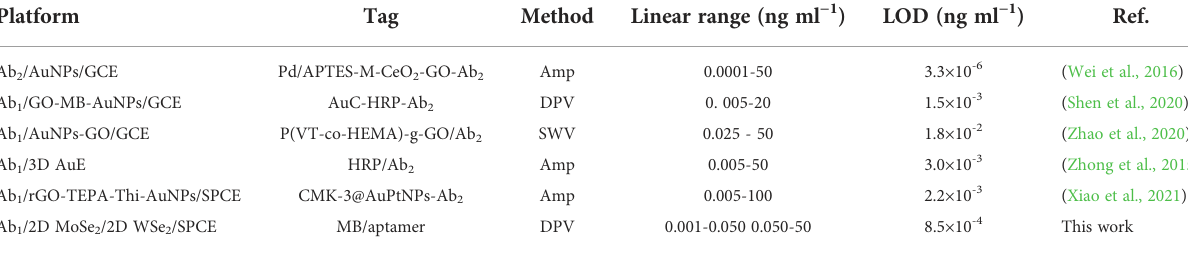
TABLE 1 Comparison of detection performance of the proposed biosensor with various AFP immunosensors. Platform